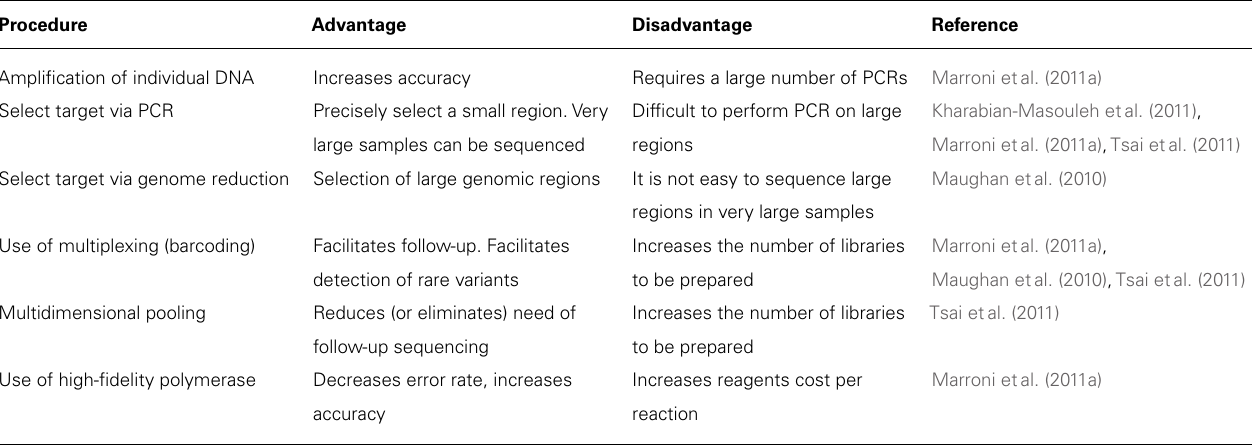
Table 1 | List of different procedures applied to the basic pooled NGS approach with the respective advantages and